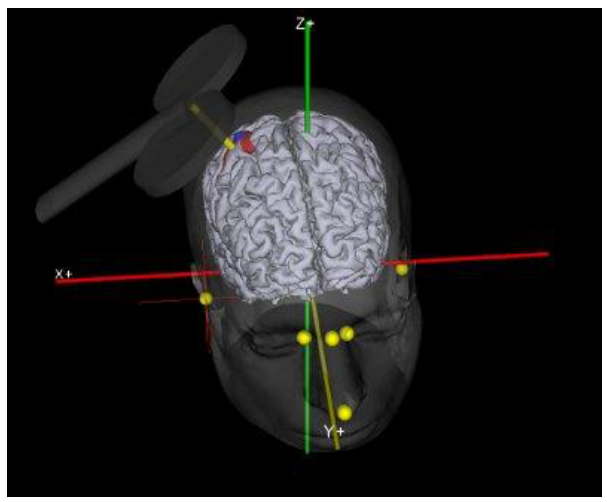
Figure 3. Coil Position. In Figure 3 was show the exact coil location for motor cortex